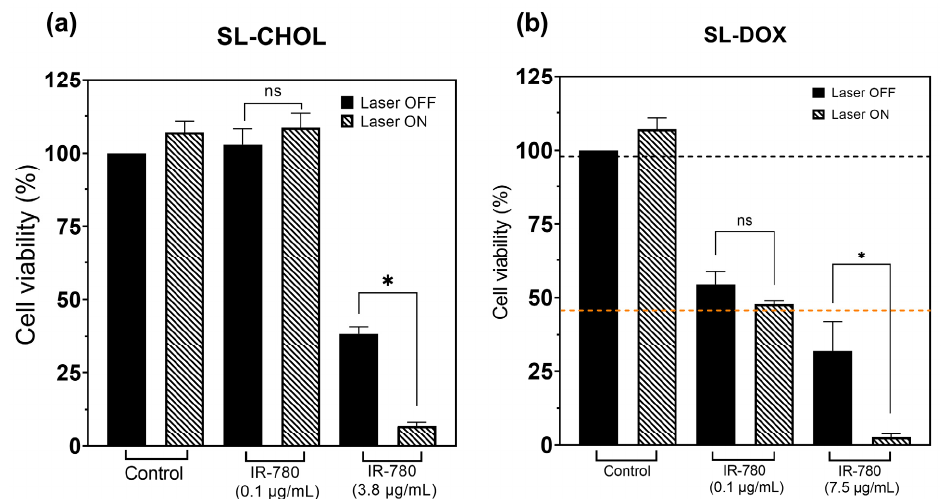
Figure 7. Photothermal effect on cell viability: ( a ) MTT data of SL-CHOL with and without laser irradiation (PTT); ( b ) MTT data of SL-DOX with and without PTT. The orange and black horizontal lines in ( b ) indicate the cell viabilities of free DOX at 7.5 μ g/mL (37 °C) and a control sample in a thermal bath experiment maintained at 43 °C for 4 h [21], respectively. The temperature profiles during PTT of representative samples for both figures ( a ) and ( b ) are shown in the Supplementary Material. The highest thermal dose is achieved with SL-DOX containing 7.5 μ g/mL IR-780. * p < 0.05 ( t -test).